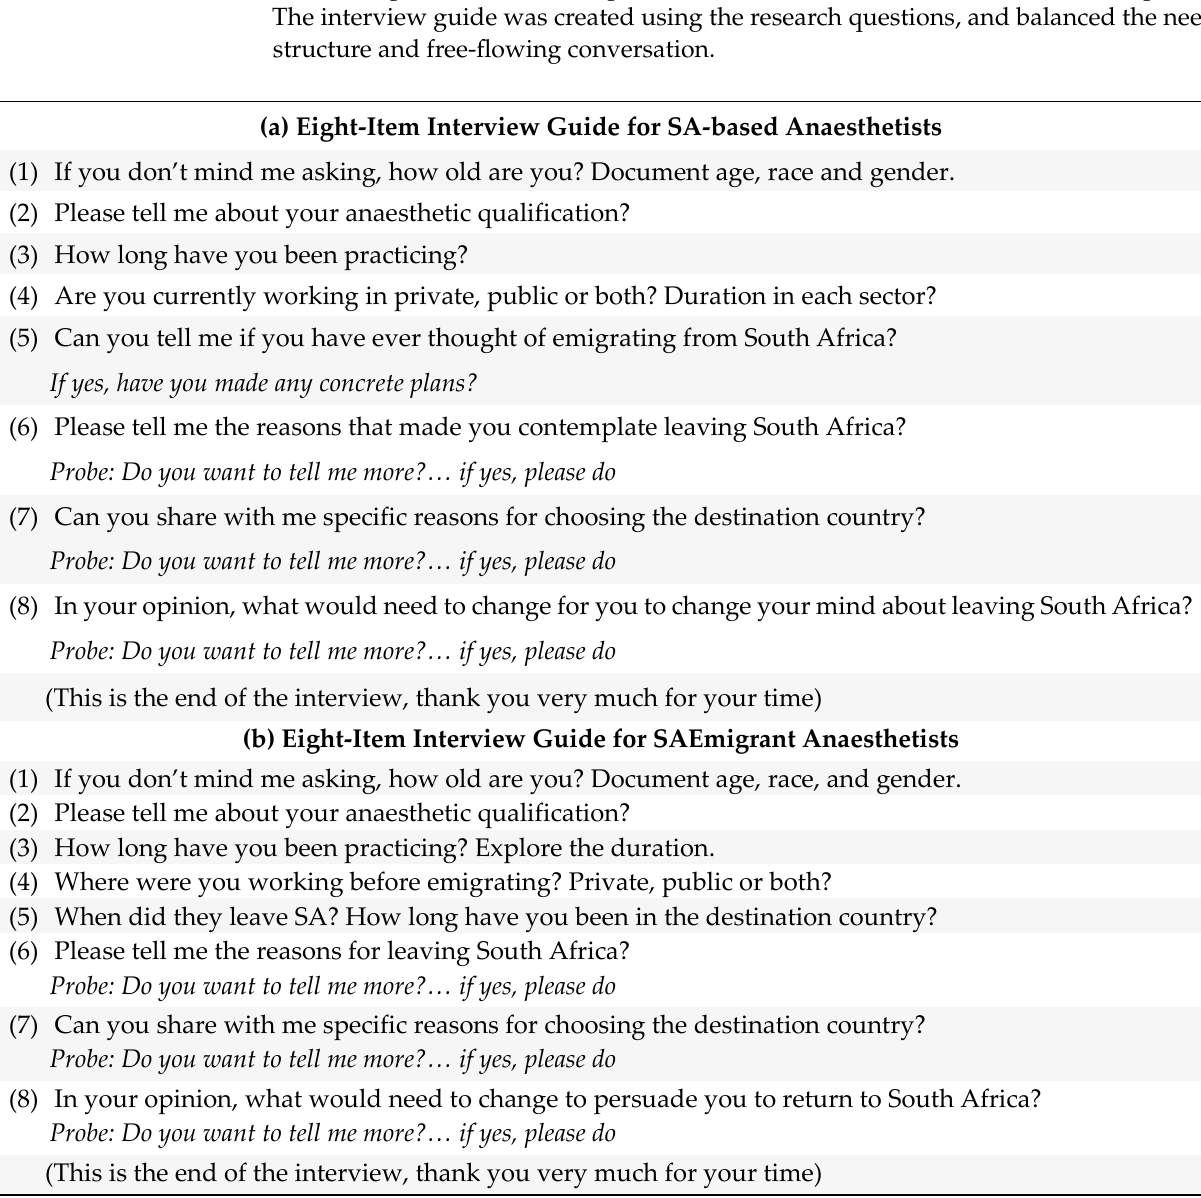
Figure 1. ( a ) Eight-item interview guide for SA-based anaesthetists. ( b ) Eight-item interview guide for South African emigrant anaesthetists.